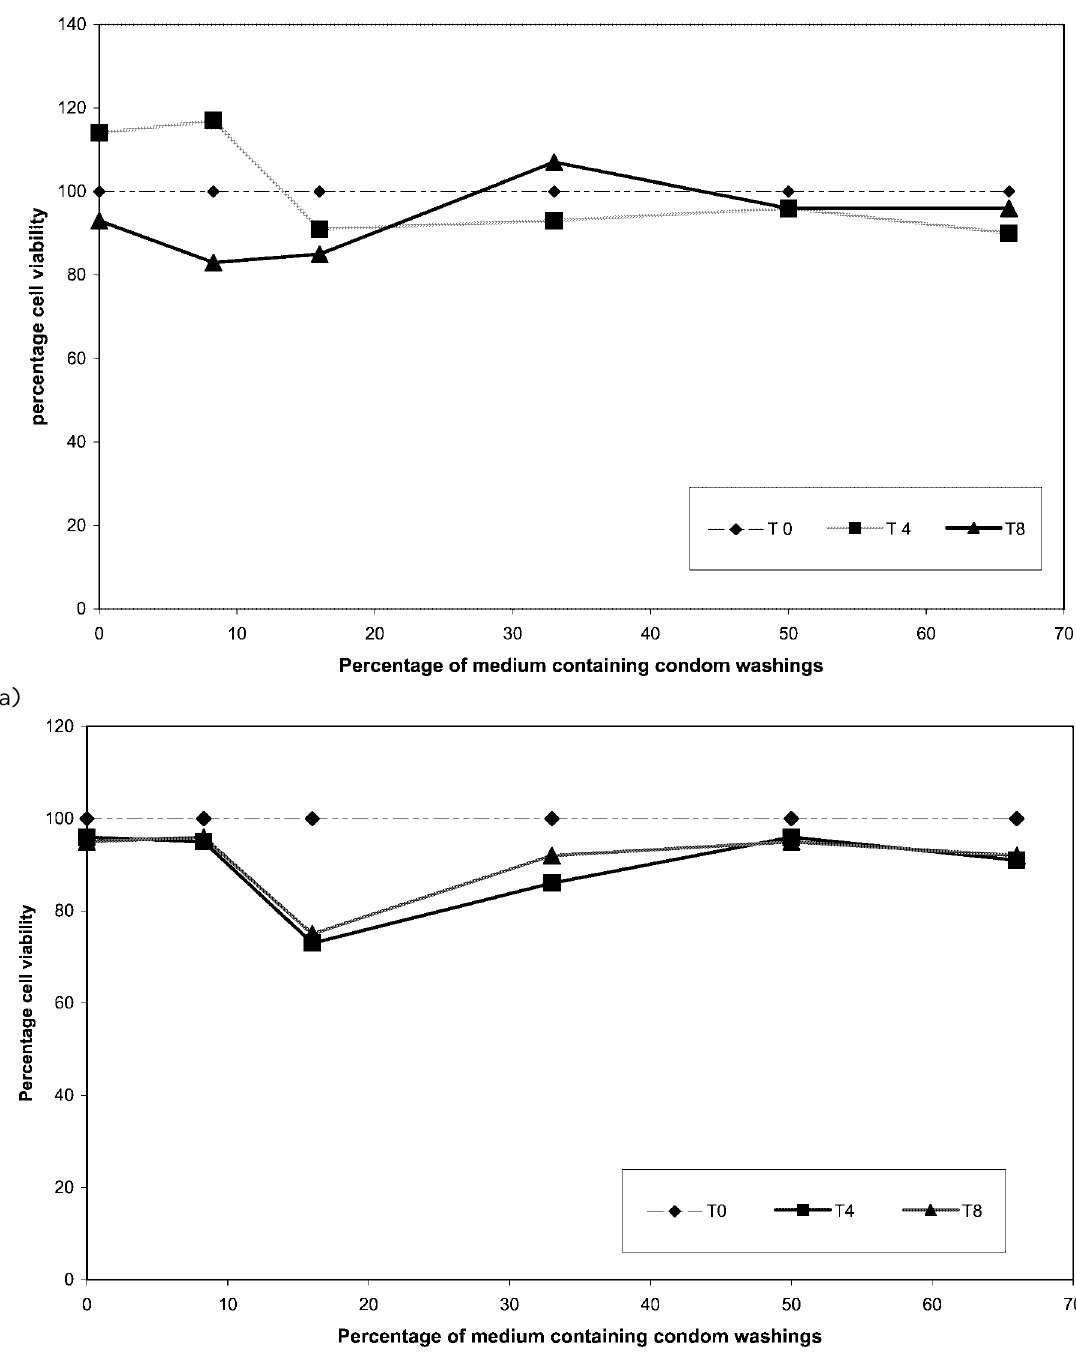
Fig. 2. Cell viability (MTT assay) following exposure of cells to washings derived from: (a) non-lubricated condoms, (b) lubricated condoms, and (c) flavored